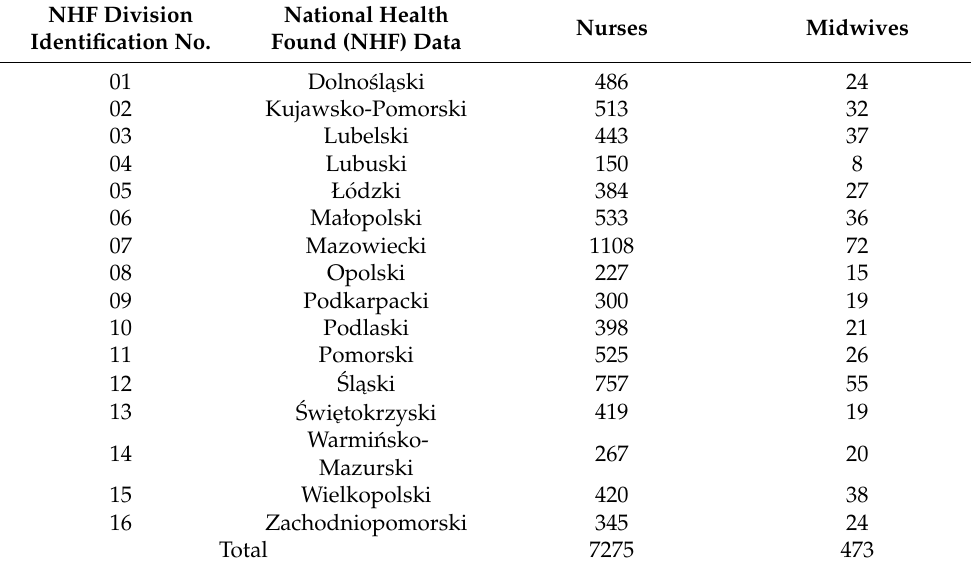
Table 1. The number of nurses and midwives who issue prescriptions for reimbursable items in the provinces where the prescriptions were